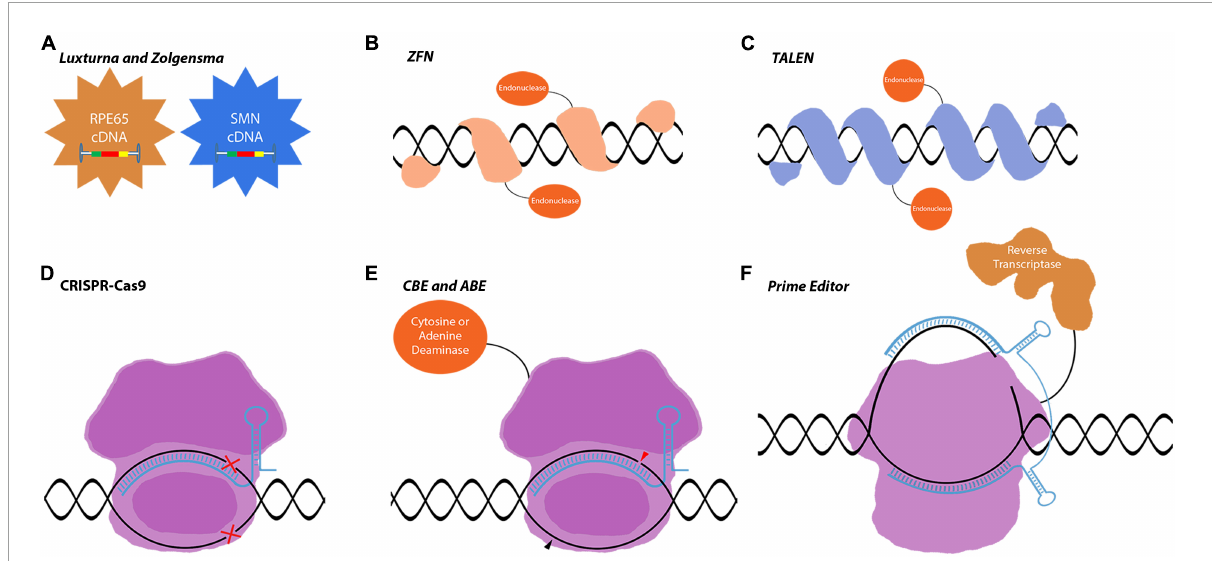
FIGURE1 Gene editing tools used in gene replacement and gene correction techniques. (A) Luxturna and Zolgensma are AAV-based drugs that replace the mutant gene-of-interest with the wild-type copy. (B–F) Gene correction relies on more intricate tools to edit the genome and precisely correct mutations in the target gene. This enables the correction of mutations in large genes that do not fit into viral vectors. (B–D) These first-generation gene correction tools rely on DNA-repair mechanisms to correct mutations. (E,F) CBEs, ABEs, and prime editors are very precise gene editing tools that can correct point mutations. Images are modified from crystal structures of proteins (Protein Data Bank: